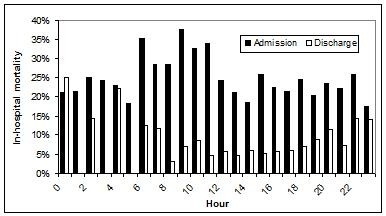
Mortality associated with hour of admission to and discharge from ICU.